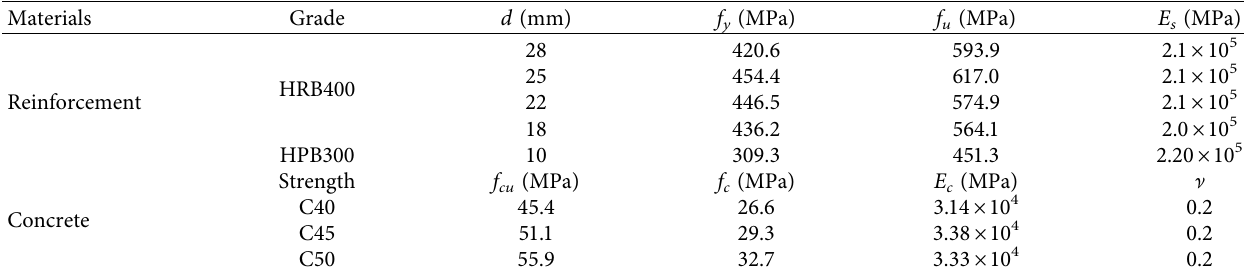
Table 1: Mechanical properties of materials.